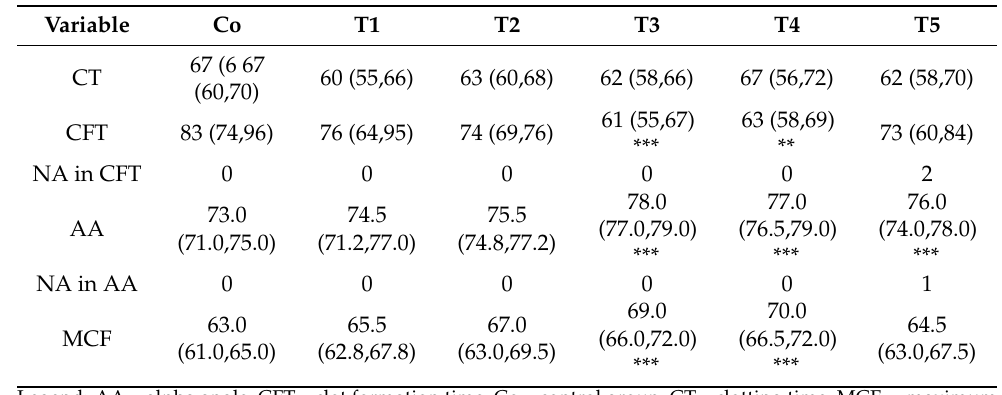
Table 3. Descriptive statistics of CT, CFT, AA, and MCF in EXTEM in high-risk patients during pregnancy, after the postpartum period, and in the control group. Data are presented in the form of medians and interquartile ranges.